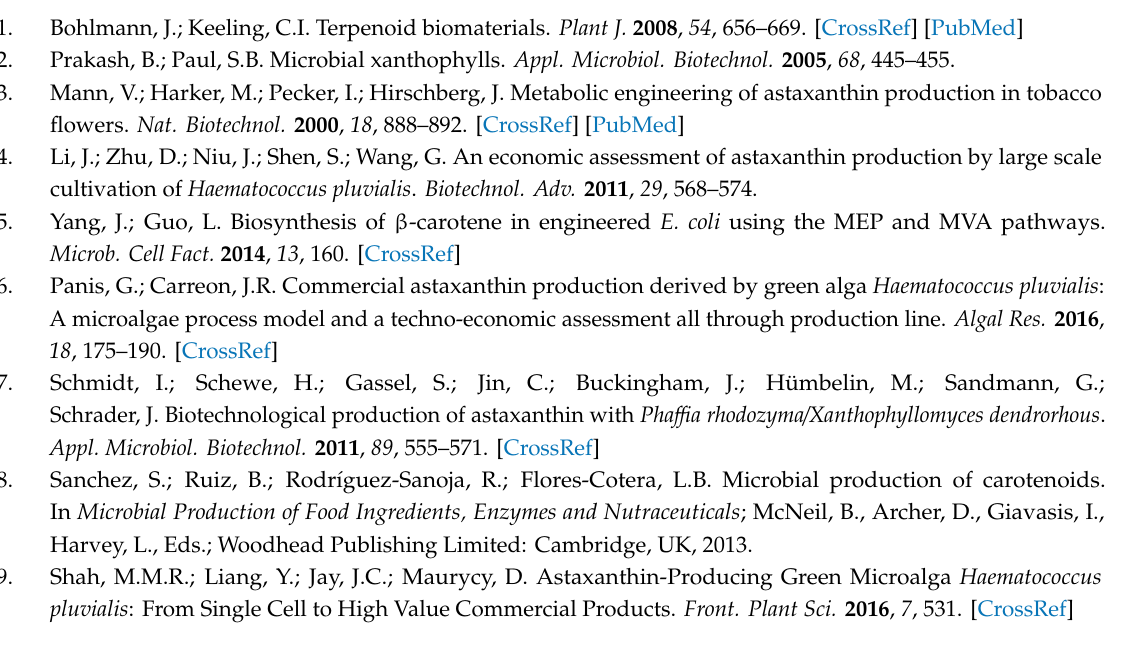
Figure S1. HPLC profile of carotenoids produced after 168 h of fed-batch fermentation of ST7976 (iso 3). Table S1. Production of carotenoids by the strains generated in this study. Supplementary sequences: Sequences of synthetic genes used in the study. Titers were quantified by HPLC analysis. Values are the average of the triplicates. The molar ratio ( β -ketolase: β -hydroxylase) is indicated between brackets. The isolate number is indicated after the abbreviation ‘iso’Table S2. List of Yarrowia lipolytica engineered strains. Table S3. List of plasmids used in this study. Table S4. List of primers used in this study. Table S5. List of BioBricks used in this